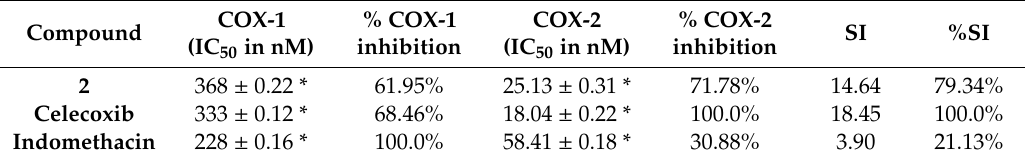
Table 3. In vitro COX-1 / COX-2 inhibition assay ( N = 3, Mean ±